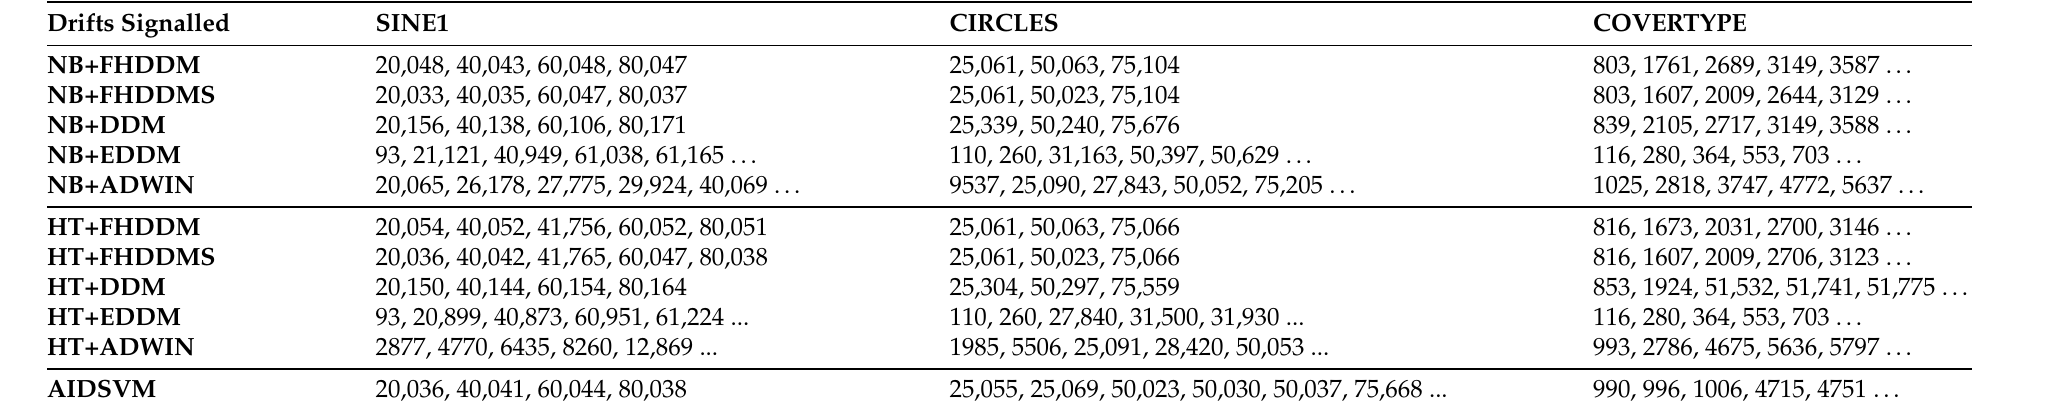
Table 4. Drift points detected by the compared models. Drift is detected the same regions, mostly observed for the SINE1 and CIRCLES datasets. Here, we have only shown the first five detections. The presence of ellipsis shows that the sequence is longer. Clear concept drift is seen in SINE1 around theoretical positions 20,000, 40,000 and 60,000, and for CIRCLES at positions 25,000, 50,000 and 75,000. COVERTYPE dataset seems to have a mixture of abrupt and gradual concept